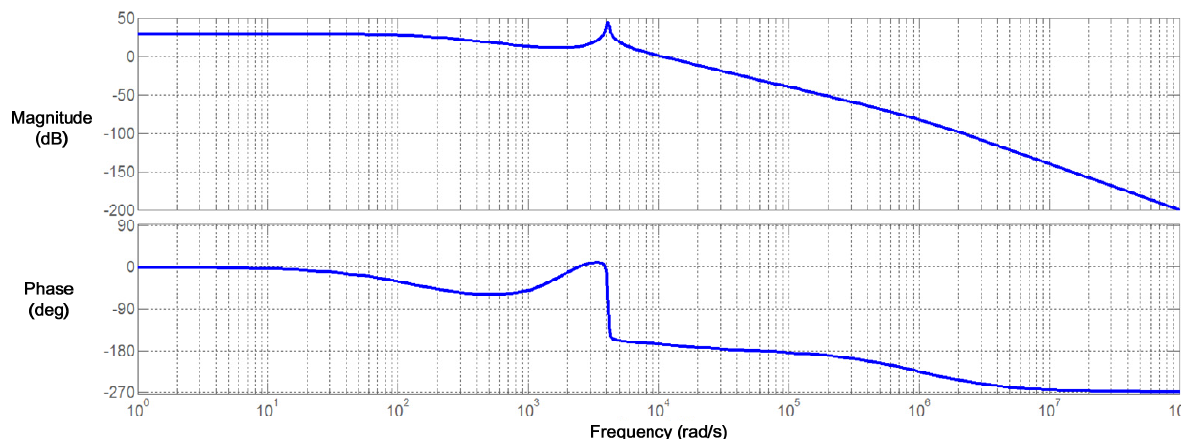
Figure 11. Bode diagram of